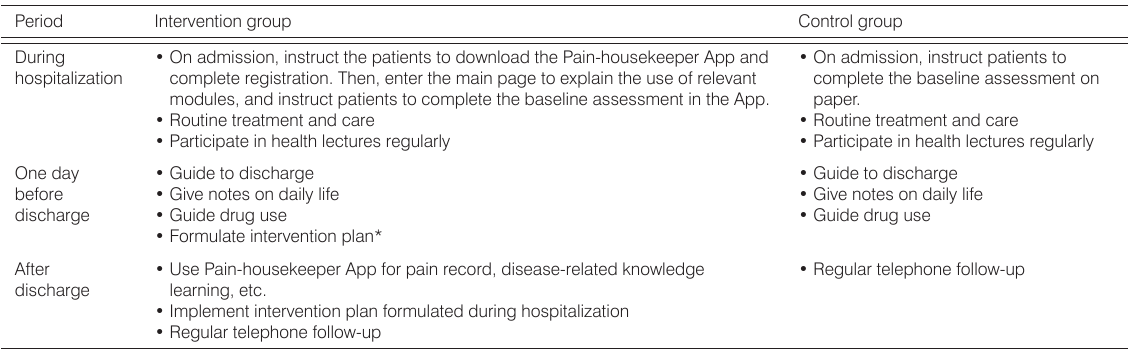
Table 1. Intervention plan for two groups of patients.